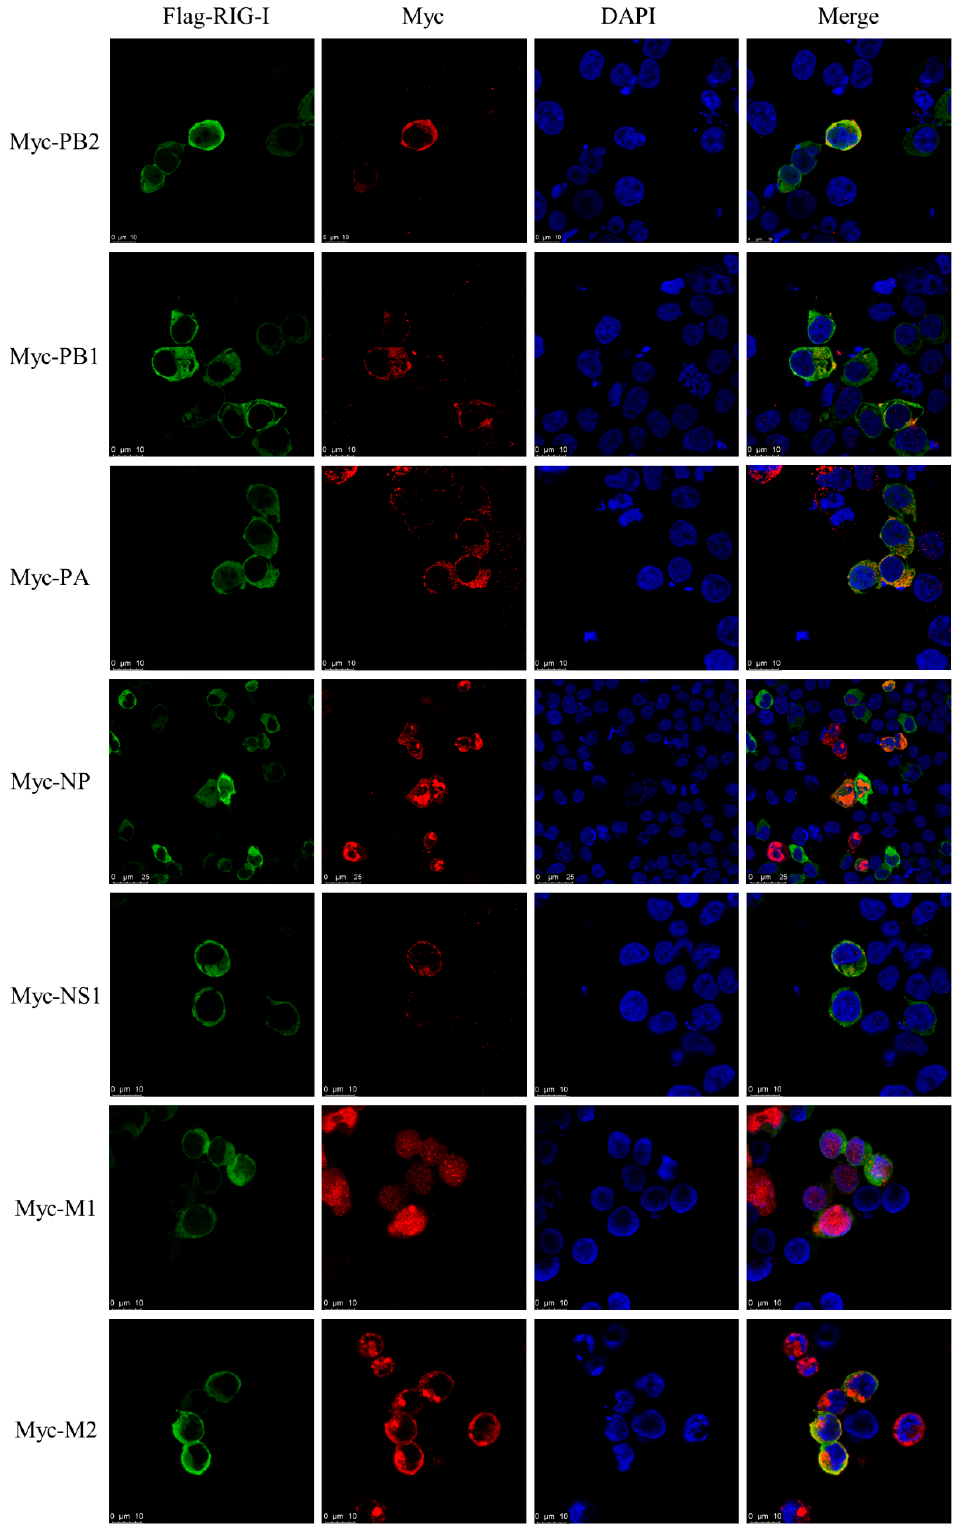
Figure 7. Interactions between CIV proteins and canine RIG-I observed by IFA in co-overexpression. IFA of canine RIG-I protein with Flag- or Myc-tagged CIV viral proteins (PB2, PB1, PA, NP, NS1, M1, and M2) in HEK 293T cells.